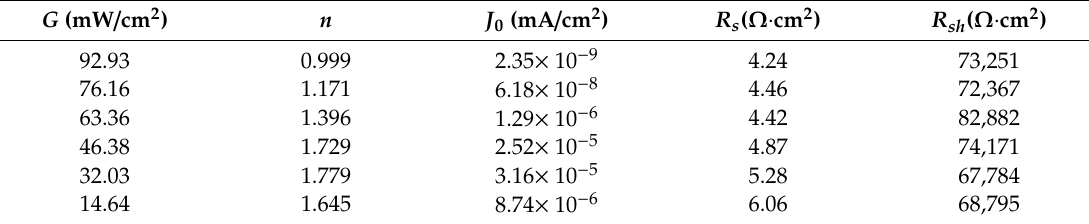
Table 2. Extraction of the one-diode model parameters of the CdTe solar cell #1.